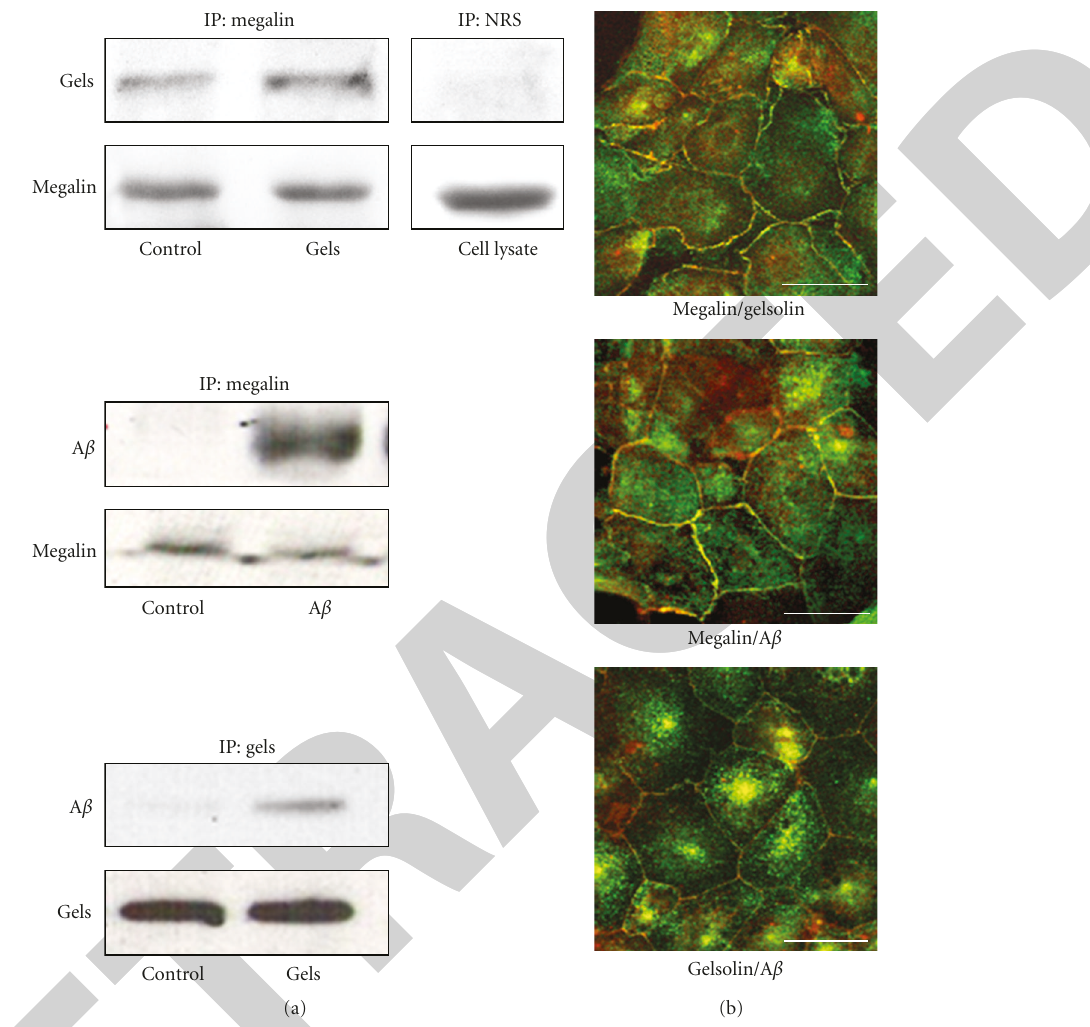
Figure 1: Gelsolin expression in choroid plexus epithelial cells. (a) Antimegalin immunoprecipitation of rat choroid plexus cell extracts, followed by blotting with respective antibodies, revealed an association between megalin, endogenous gelsolin, the exogenously added secreted gelsolin form, and the exogenously added A β . Immunoprecipitation with nonspecific serum showed no unspecific A β association. Binding of gelsolin with exogenously added A β was also observed. Representative blots are shown ( n = 4). (b) Megalin colocalized with gelsolin and exogenously added A β in choroid plexus cultures. Confocal images also show gelsolin colocalization with A β . Scale bars = 10 μ m. IP: Immunoprecipitation; NRS: normal rabbit